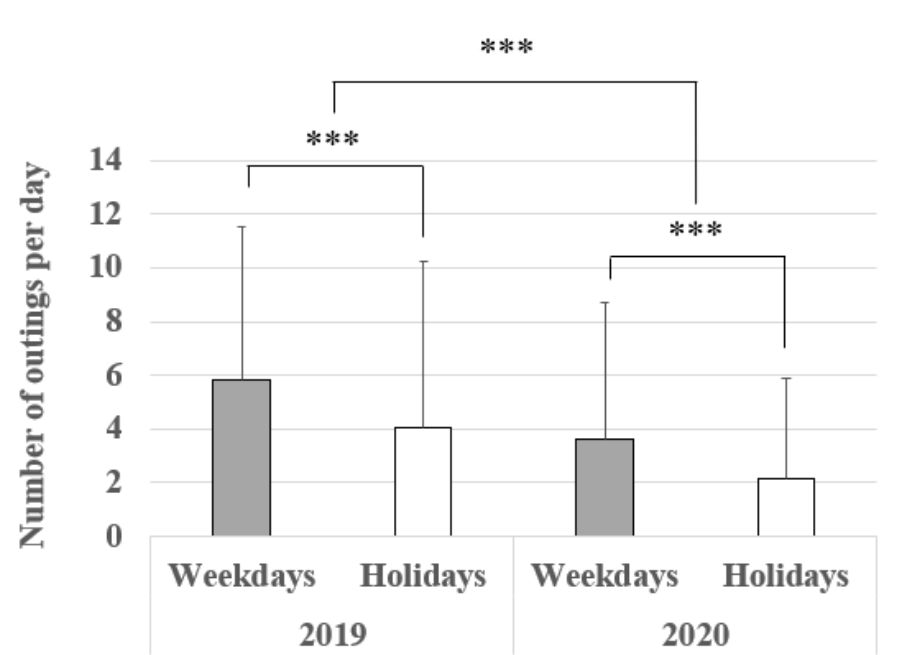
Figure 3. Number of outings per day (mean ± S.D). *** designates p < 0.001. n (2019) = 55,713 and n (2020) = 42,197.